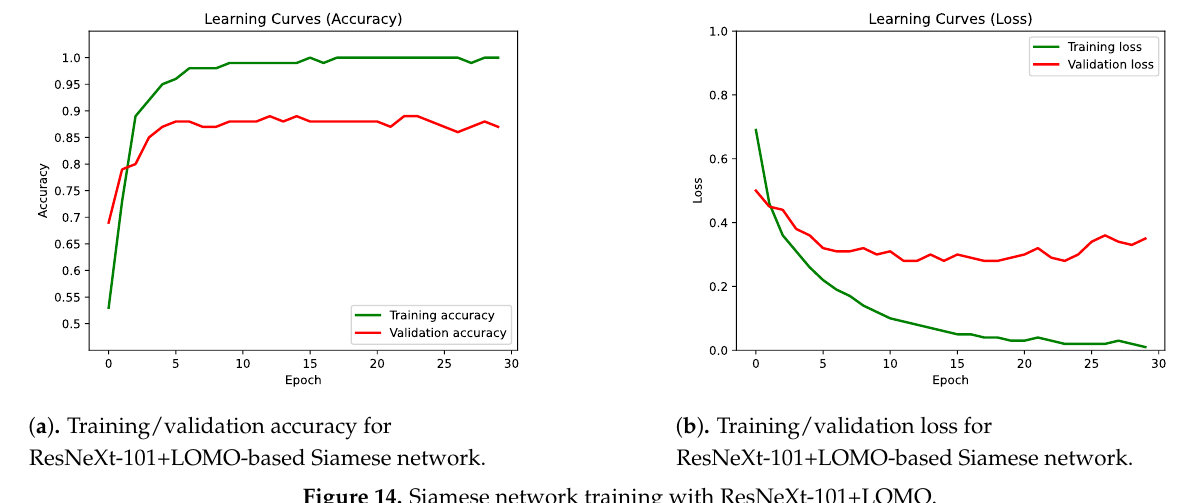
Figure 14. Siamese network training with ResNeXt-101+LOMO.